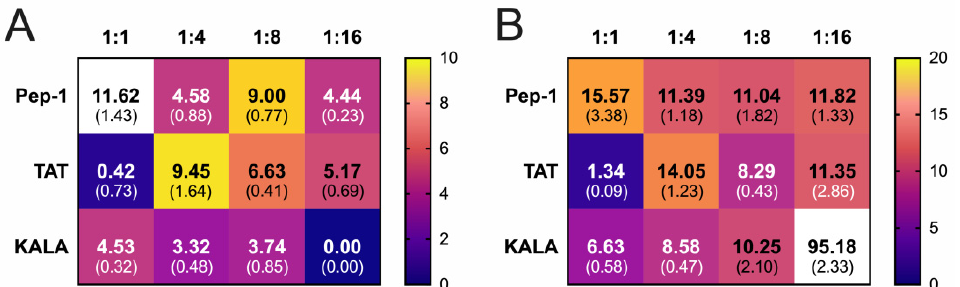
Figure 5. Effect of 48 h culture in the presence of complexes in CRs of 1:1, 1:4, 1:8 and 1:16. The complexes were formed using incubation of 1 μ g pmaxGFP with chosen CPPs at 21 °C for 15 min. CR, charge ratio. ( A ) Transfection efficiency. ( B ) Percent of cells with abnormal morphology. Data are presented as means, numbers in parentheses represent standard deviations.